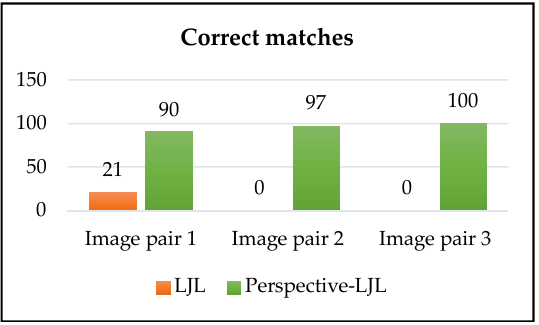
Figure 17. Comparison of the number of correctly matched line segments in fluctuant areas.